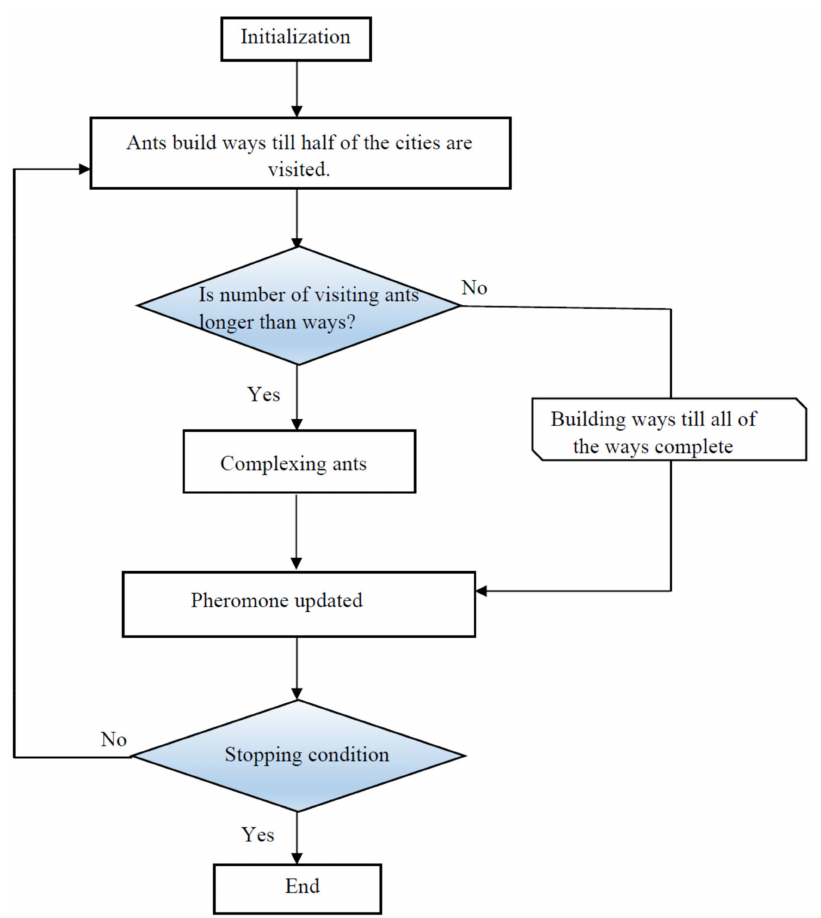
Figure 7. Flowchart of the ant colony optimization (ACO)